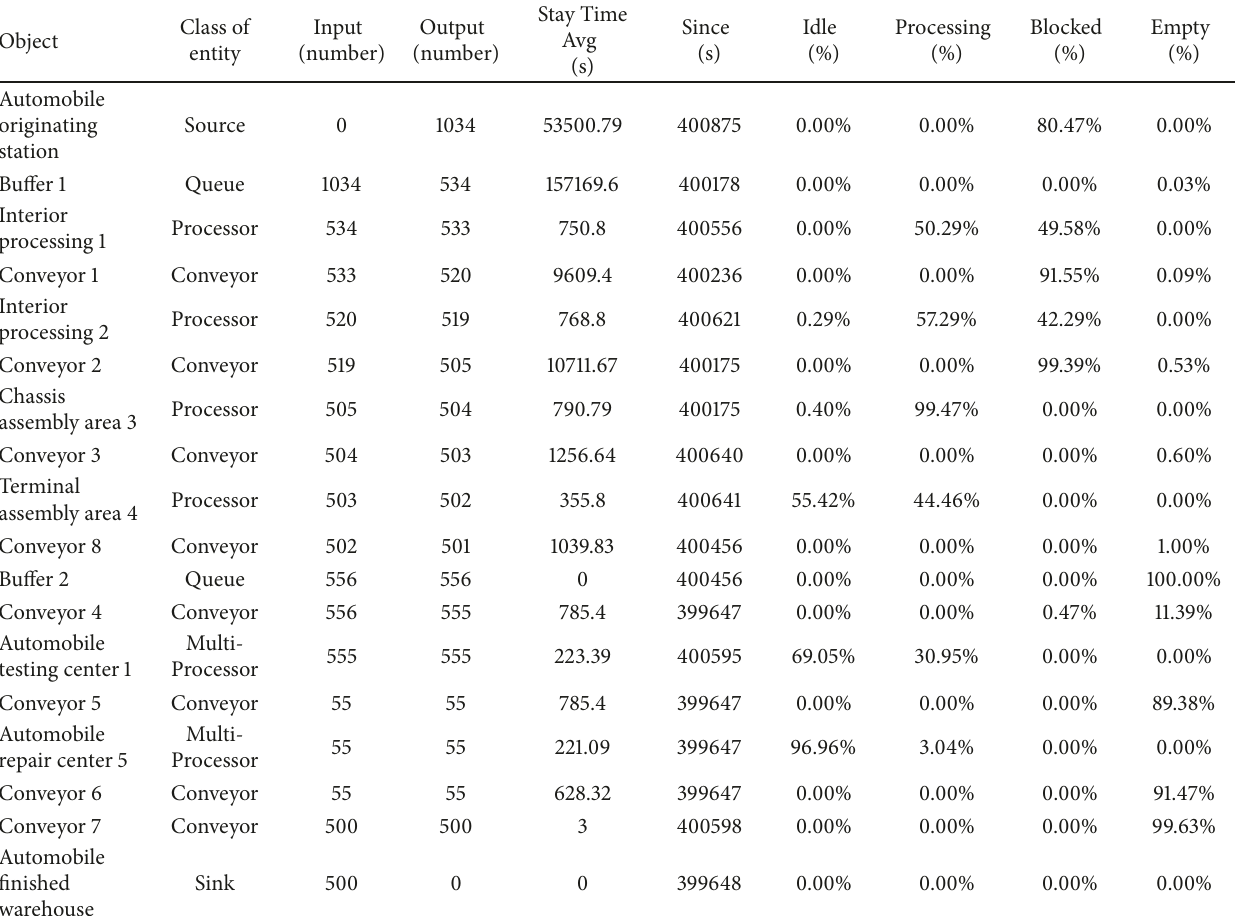
Table 3: Statistical data of mixed assembly